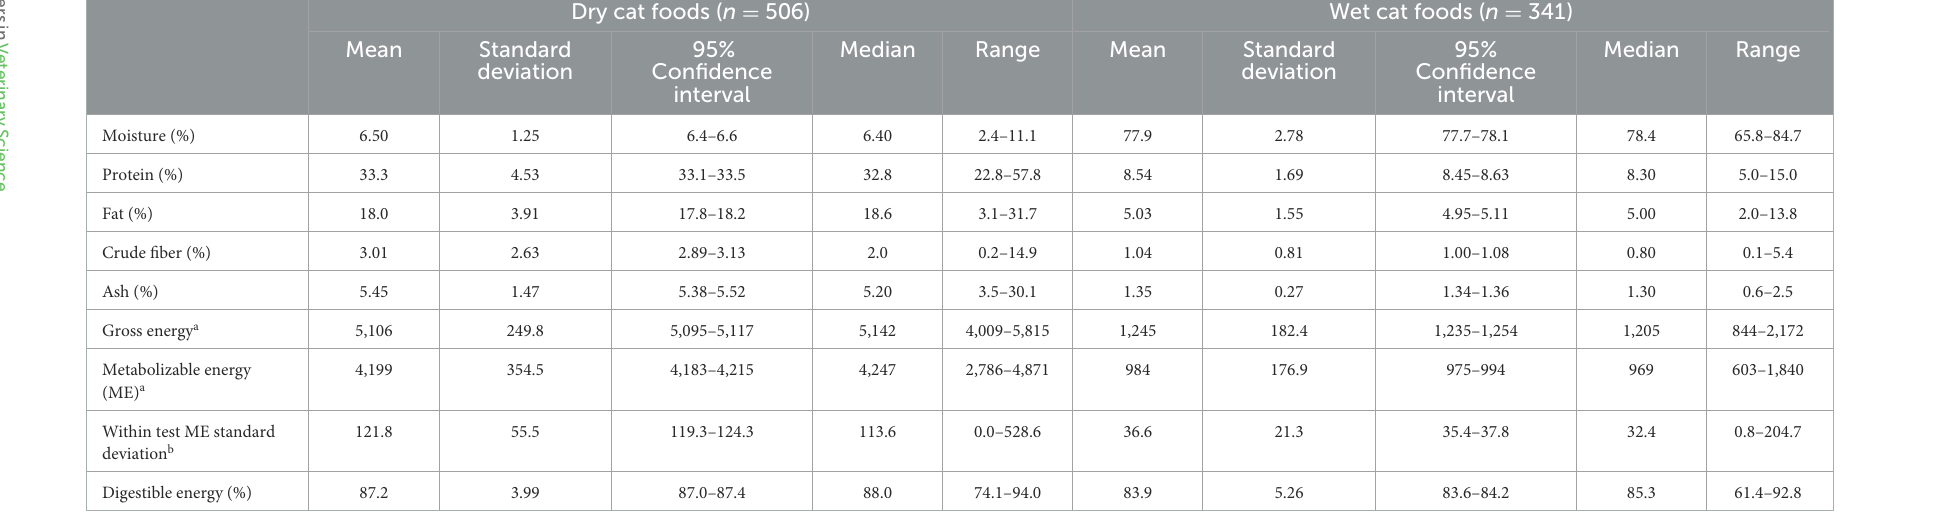
TABLE 2 Characteristics of cat foods tested.